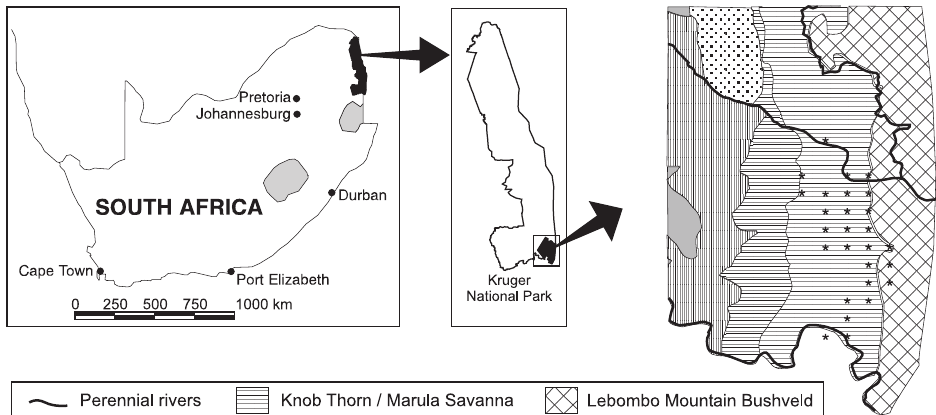
Fig. 1. The Lower Sabie region of Kruger National Park. Detail shows locations of observations (asterisks) on a coarse (5 km) grid; the ecozones and three perennial river courses are also